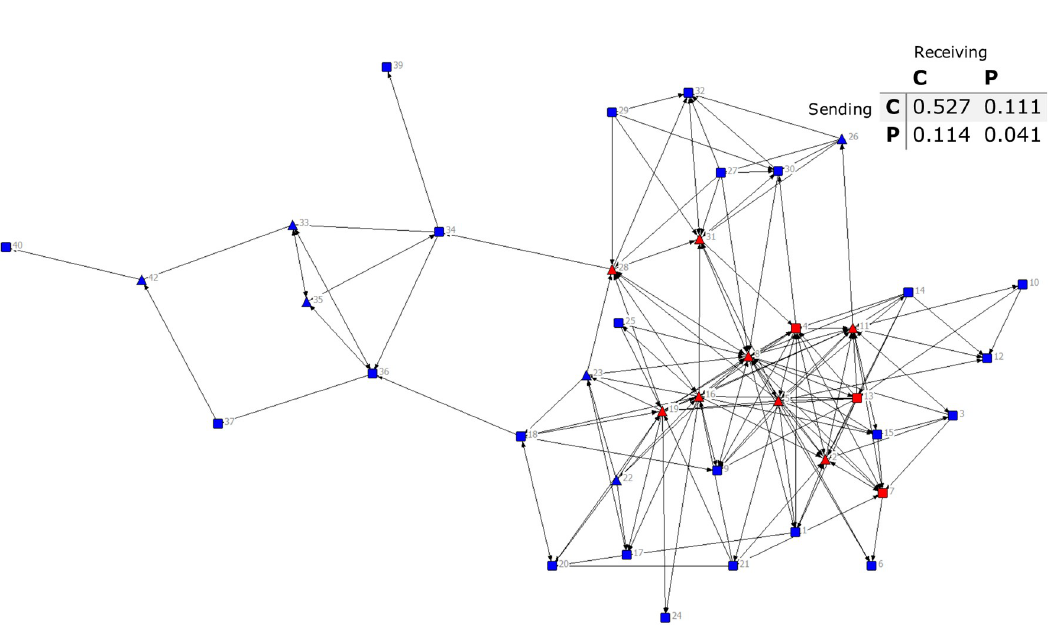
Fig 6. Sociogram of core-periphery membership in advice-giving ties. The colour of nodes represents core-periphery membership (nodes in red are core farmers and nodes in blue are periphery farmers). The node shape represents farmers’ leadership status (farmer leaders in triangles and general members in squares). The density matrix of ties between core (C) and periphery (P) farmers is on the upper right-hand side of the figure.